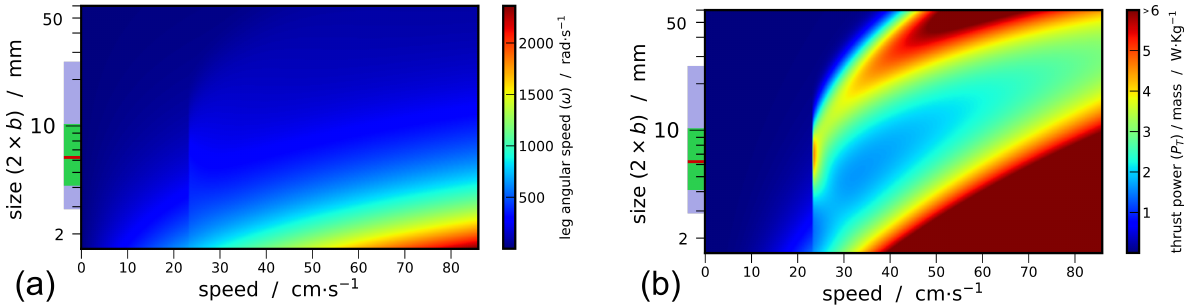
Figure 7. ( a ) Angular speed of whirligig beetles’ legs required to maintain a certain speed and ( b ) required specific thrust power as function of size and speed of the whirligig beetle. The range of sizes of whirligig beetles is highlighted in light blue on the axis, the green rectangle indicates the standard deviation of the size distribution around the mean, and the red line indicates the